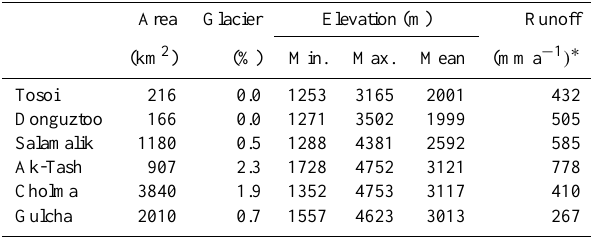
Table 1. Area, glaciation, elevation range and mean annual runoff of the studied subcatchments of the Karadarya